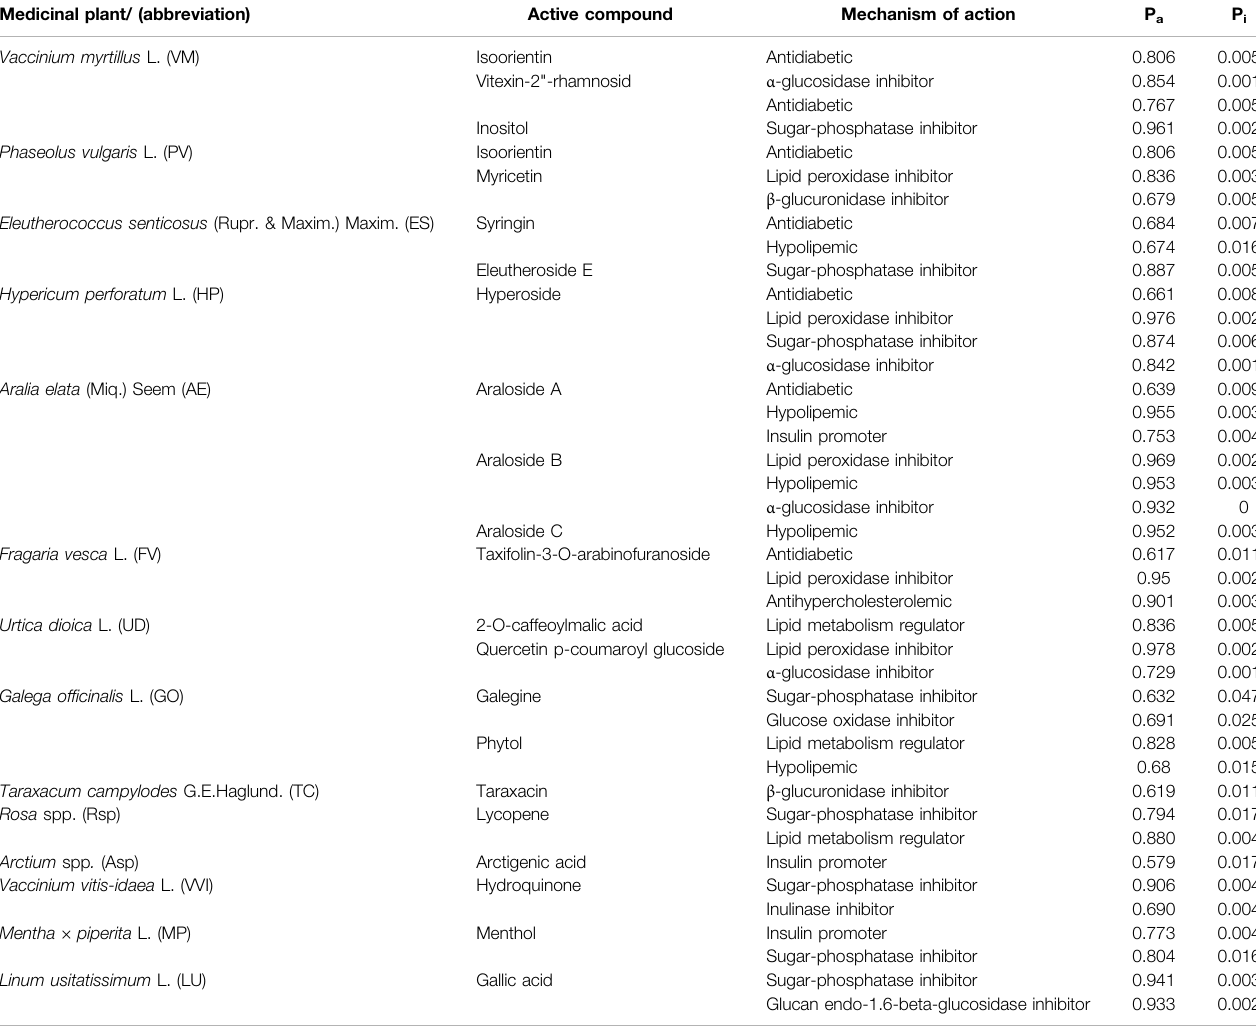
TABLE4| Theactivecompoundsfrommedicinalplantsmostoftenusedincombinationsinmedicalspeciesandprobabilityofpredicted antidiabeticmechanismsassitiated with these compounds. Medicinal plant/